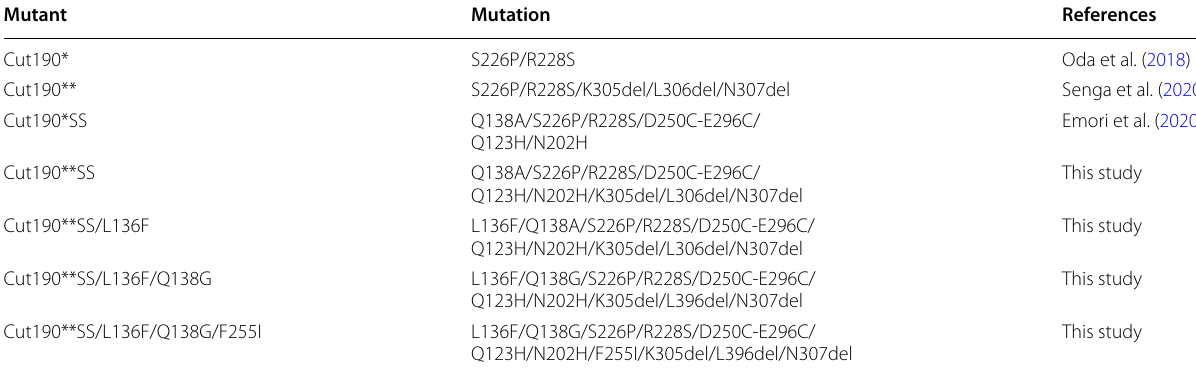
Table 1 Cut190 mutants used in this study